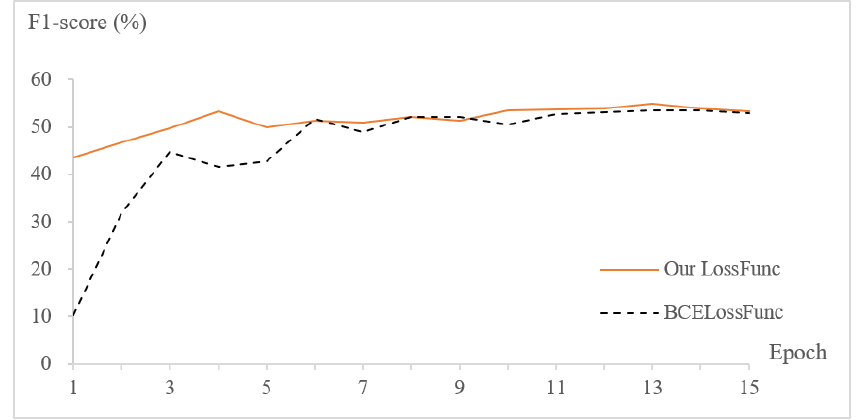
Figure 4. Convergence speed with iterations in SpanSAOKE dataset.